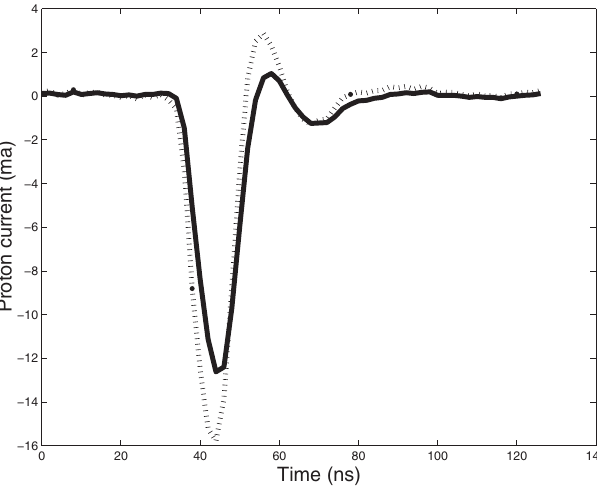
FIG. 3. Proton signal from the stripped H (cid:1) atoms as recorded by digital oscilloscope (solid line), and restored original signal from beam current monitor (dashed line).